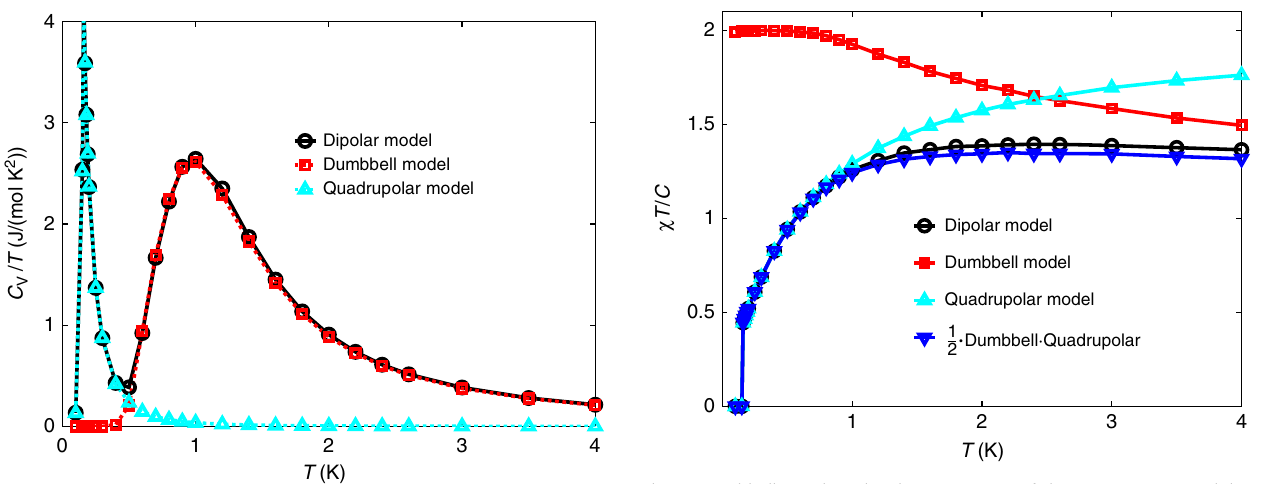
Fig. 3 Dumbbell – quadrupolar decomposition of the spin ice speci fi c heat. Speci fi c heat for the g + – DSM (black) along with the dumbbell (red) and quadrupolar (cyan) contributions